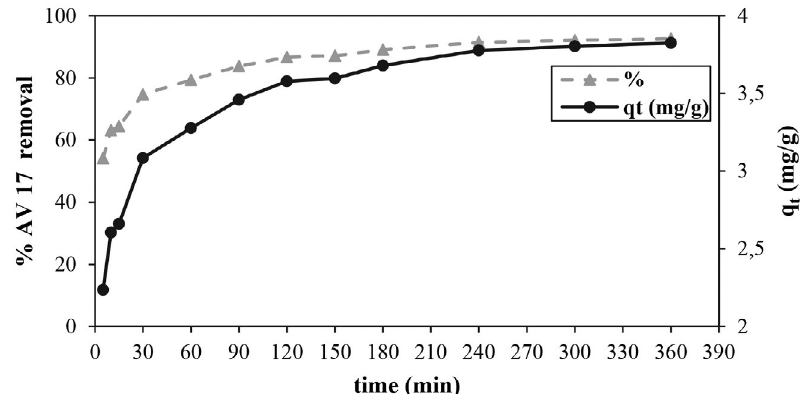
Fig. 7. Impact of agitation time on the adsorption of AV 17 by